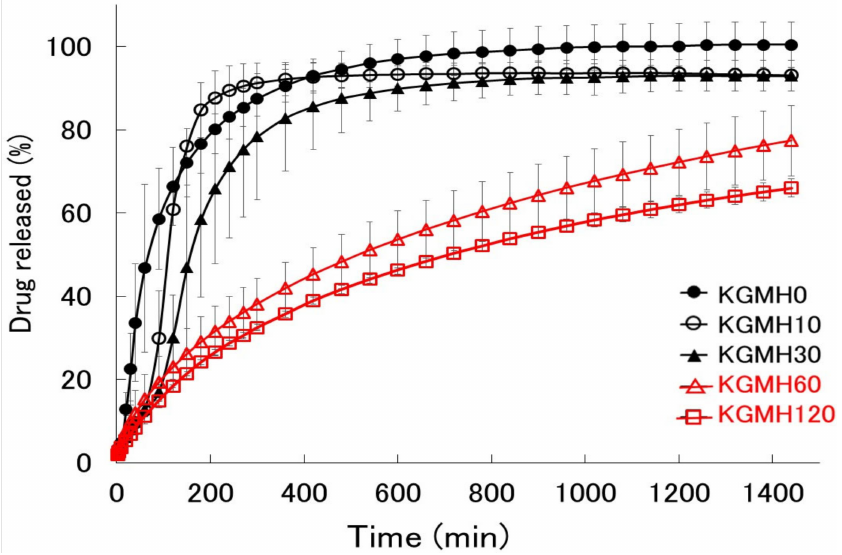
Figure 4. Drug release profiles of the polymer matrix tablets prepared from the KGMH mixtures ground for 0–120